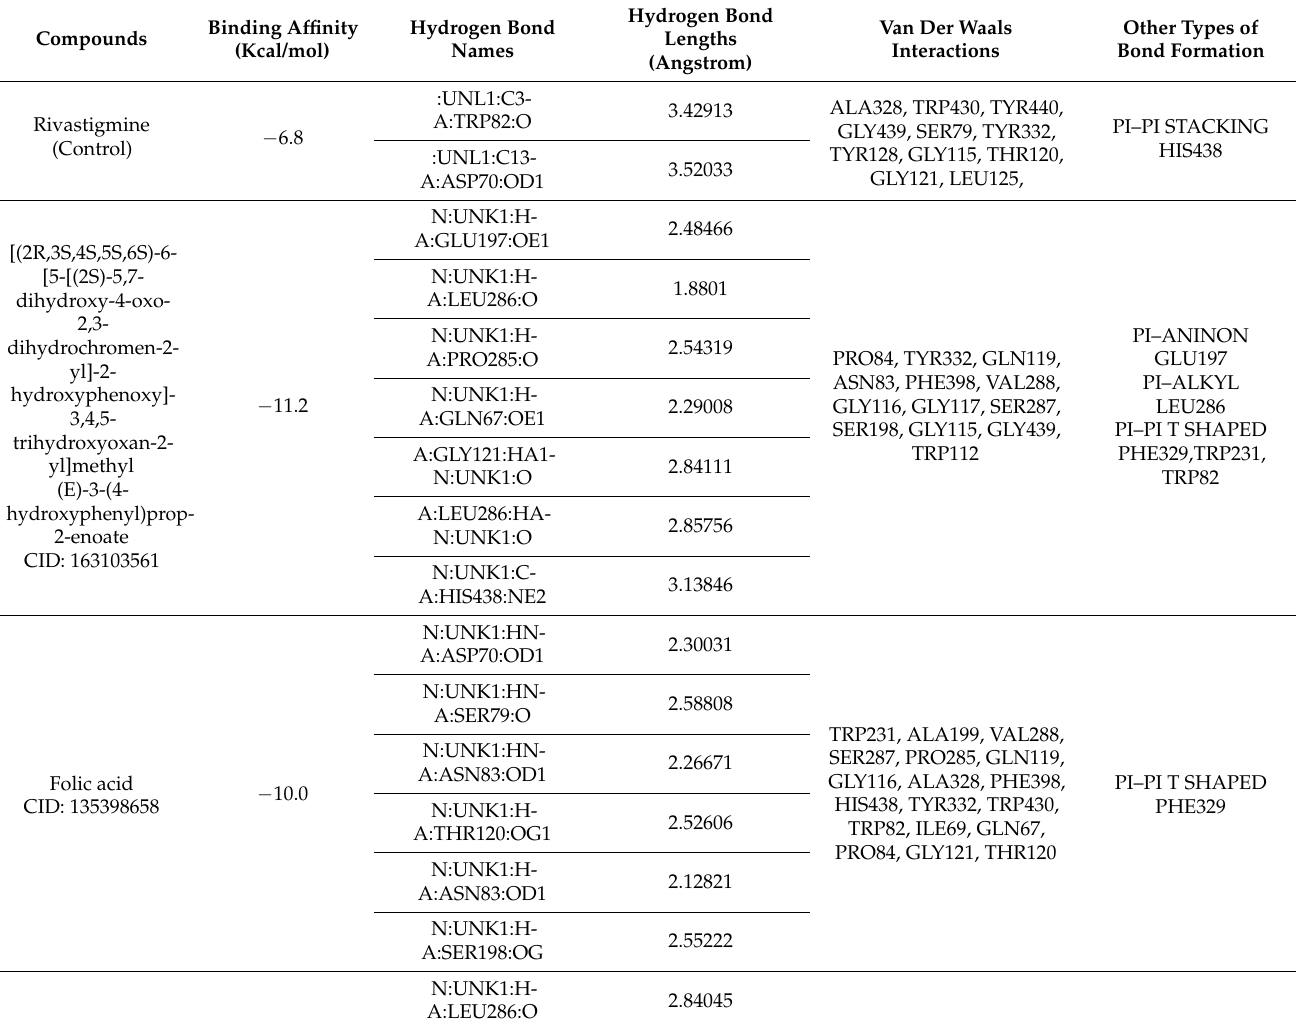
Table 2. In silico docking data was obtained from the PyRx tool after performing molecular interac- tions between the selected natural compounds and BuChE (PDB:7AIY). In the hydrogen bond names column, where UNL1, UNK1 = selected